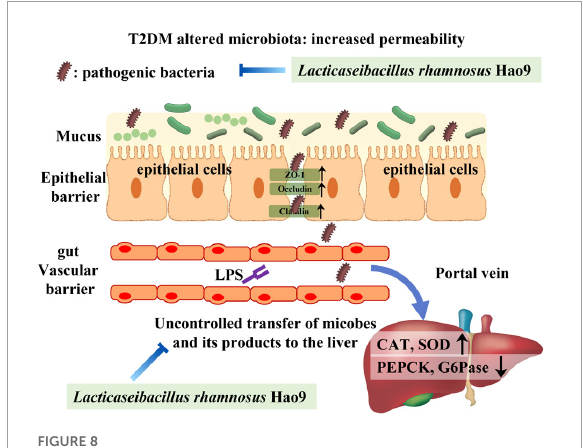
FIGURE8 Presumably Hao9 improves the pattern of type 2 diabetes mellitus (T2DM) by modulating gut